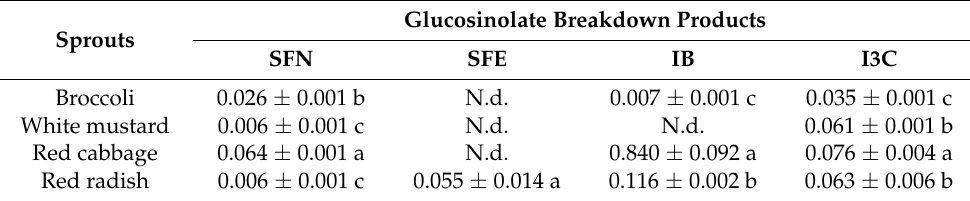
Table 4. Content of bioaccessible individual isothiocyanates and indoles (mg/100 g fw) extracted from the different sprouts as a result of the intestinal (theoretical) digestion developed directly from the raw plant material (broccoli, white mustard, red cabbage, and red radish sprouts).